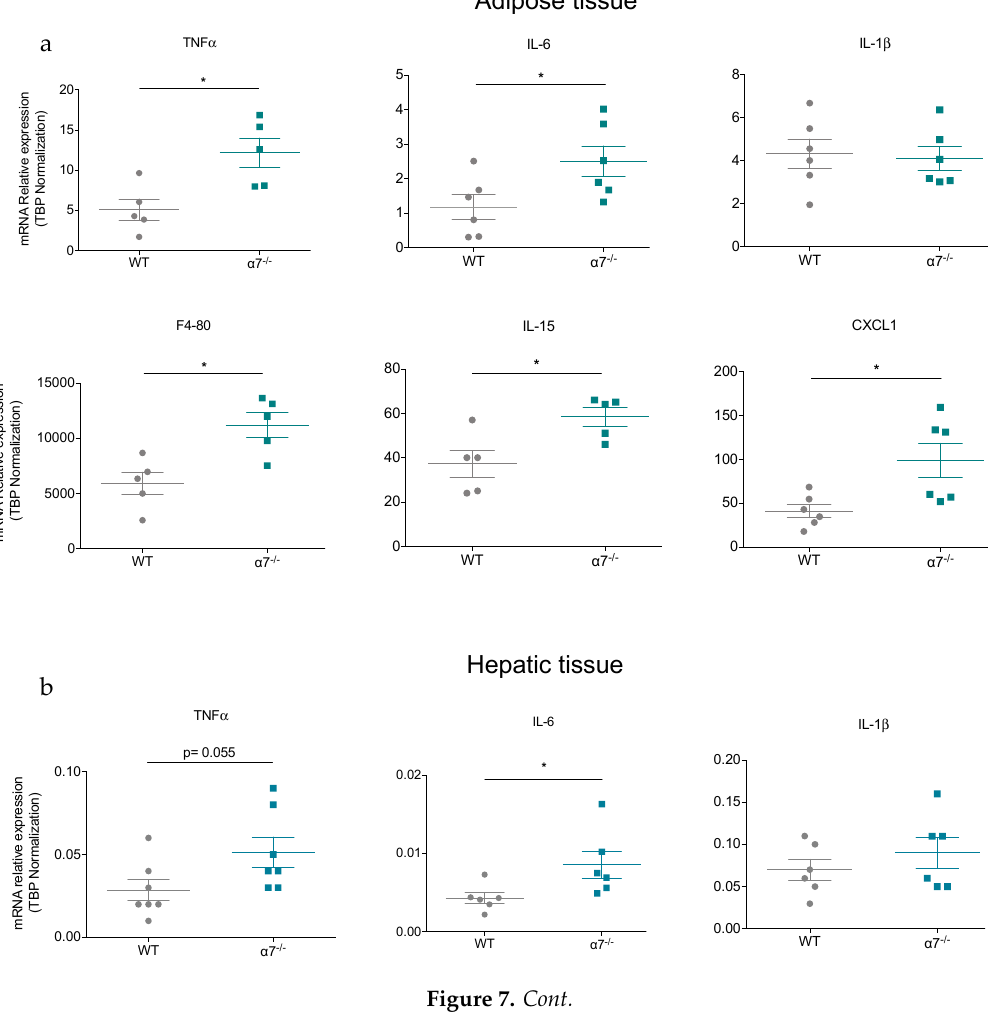
Figure 7. Twenty-five-week-old α 7 − / − mice develop adipose inflammation. mRNA expression of characteristic pro-inflammatory marker TNF α , IL-6, IL-1 β F4/80, cytokine IL-15 and chemokines